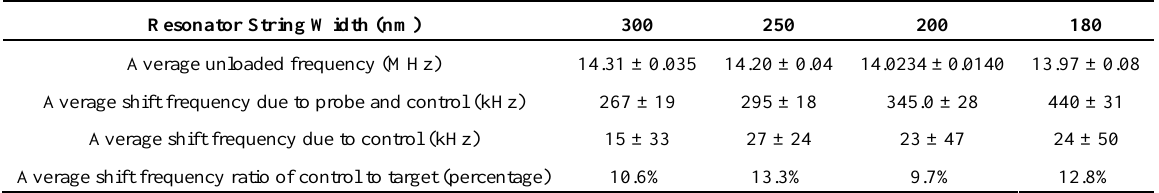
Table 3. Analysis of average resonant frequency shift of the resonator array of sample C due to the attachment of aryl film, anti-rabbit IgG, BSA and control goat